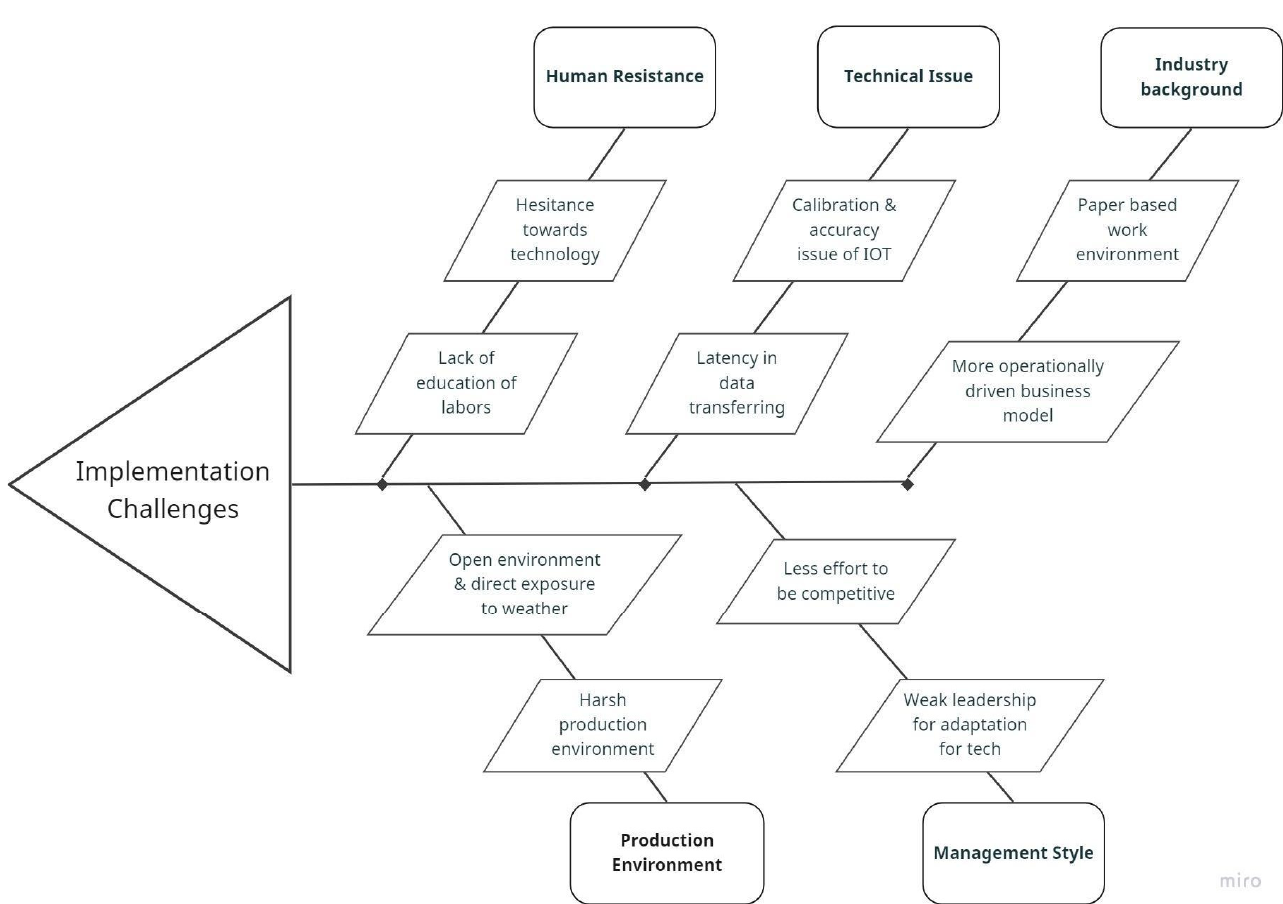
Figure 19. Fish Bone Diagram for Implementation Challenges.